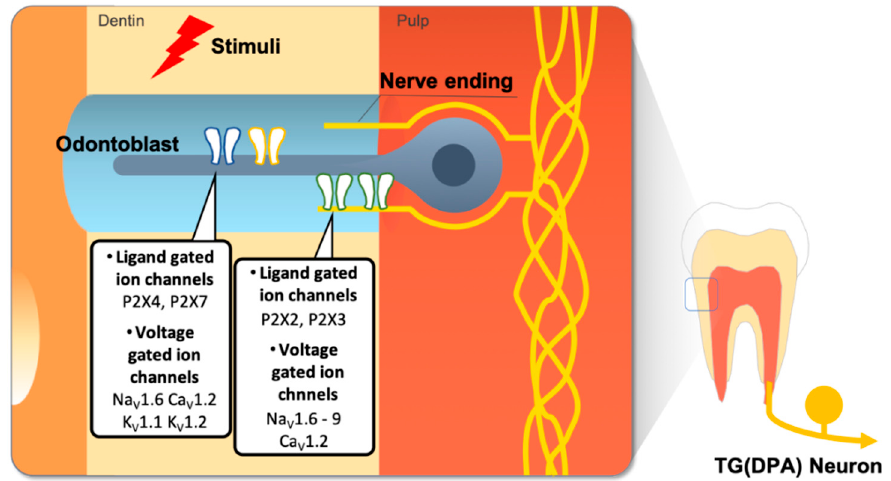
Figure 4. Other types of ion channels such as ligand gated ion channels and voltage gated ion channels expressed in the dental sensory system. ATP molecules released by adjacent odontoblast or fibroblast cells in pulp by external stimuli and they induce activation of purinergic receptors in odontoblasts or DPA neurons. Various types of voltage gated ion channels are also expressed in dental pain sensory cells but their functions are not clearly revealed.